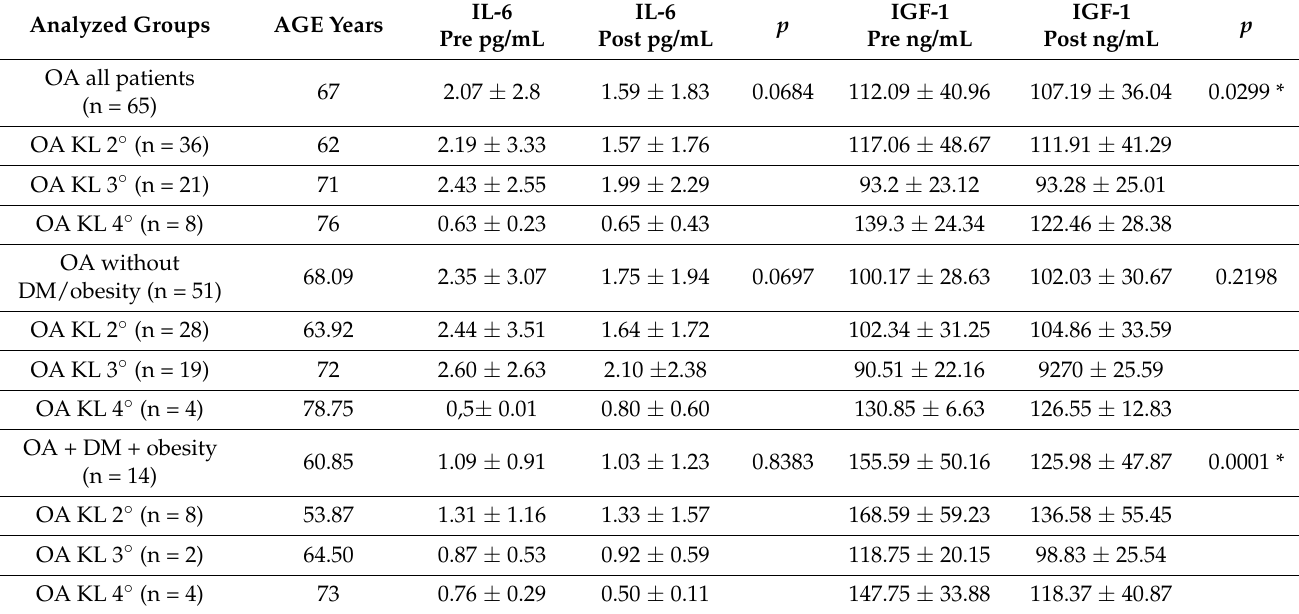
Table 1. Age and outcome variables (IGF-1 and IL-6) before-and after treatment, according to osteoarthritis (OA) Kellgren-Lawrence (KL) grades, and if diabetic and obese patients were included or